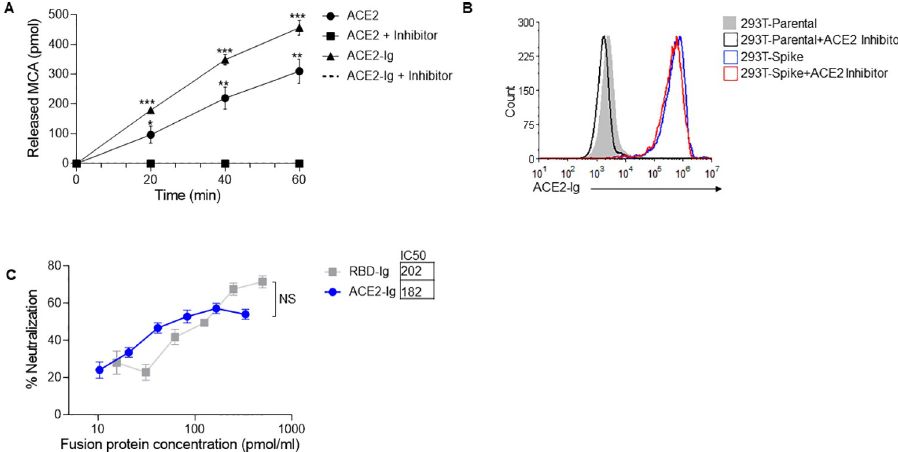
Fig 2. ACE2-Ig and RBD-Ig inhibits in vitro SARS-CoV-2 infection. (A) ACE2 enzymatic activity assay. Recombinant human ACE2 and ACE2-Ig were incubated with and without an ACE2 inhibitor, then MCA based peptide substrate was added and plate was immediately inserted in the fluorescent plate reader. � p < 0.005, �� p < 0.0005, ��� p < 0.00005, Student’s t-test as compared to same treatment with inhibitor. (B) Staining of 293T-Spike cells with ACE2-Ig which was previously incubated for 15 minutes with or without an ACE2 inhibitor. (C) Plaque reduction neutralization test. Vero E6 cells were infected with SARS-CoV-2 and treated with increasing concentrations